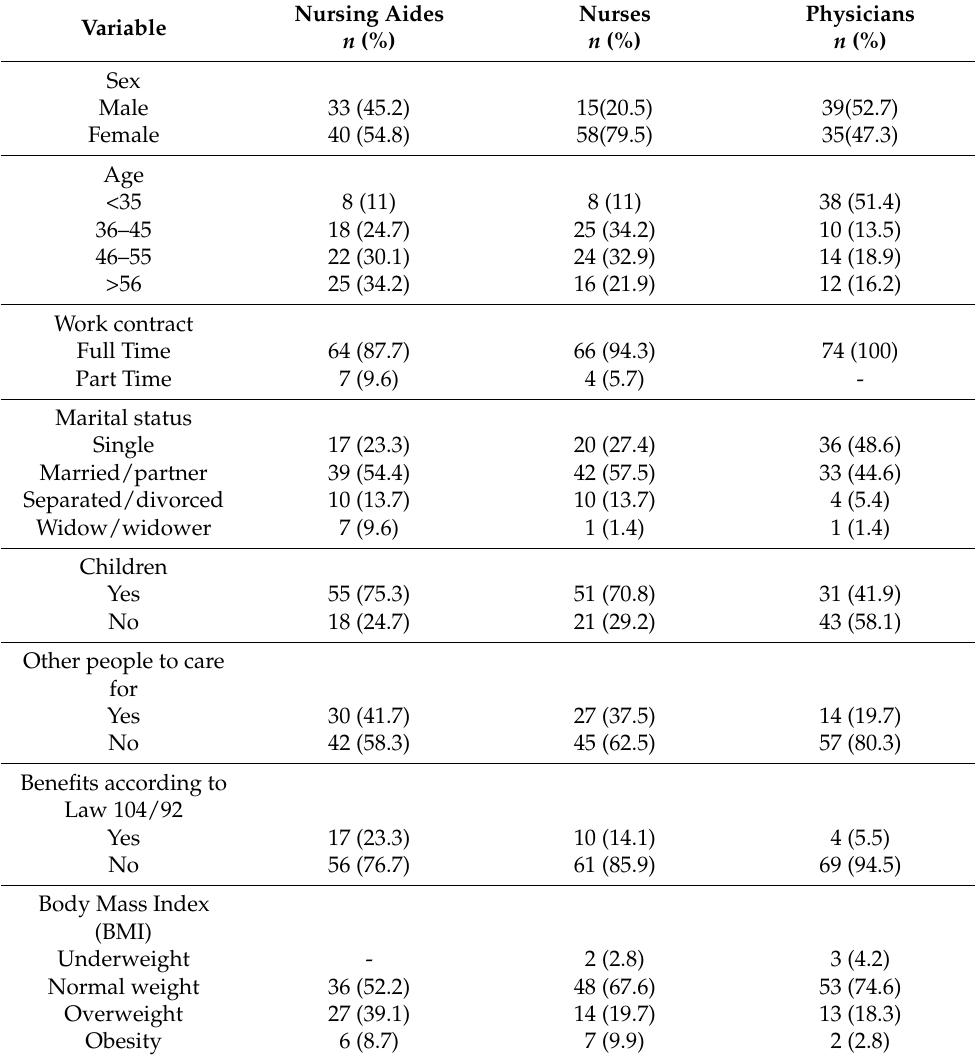
Table 1. Socio-demographic characteristics among study